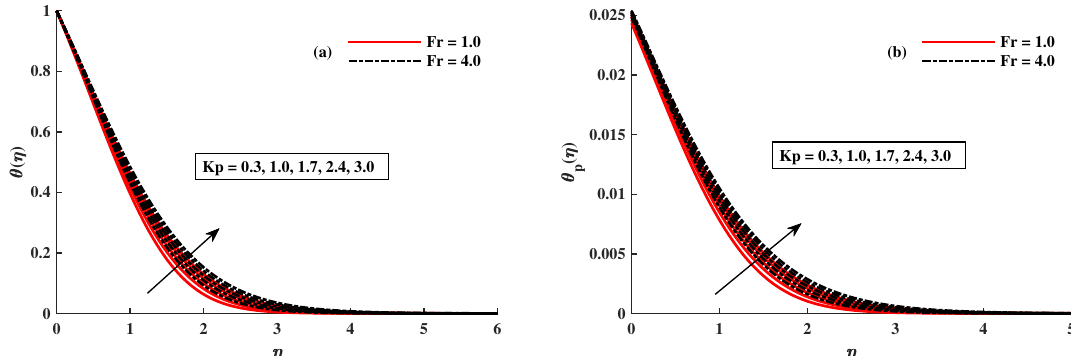
Figure 5. Variation of K p to influence the fluid and dust velocity profile.